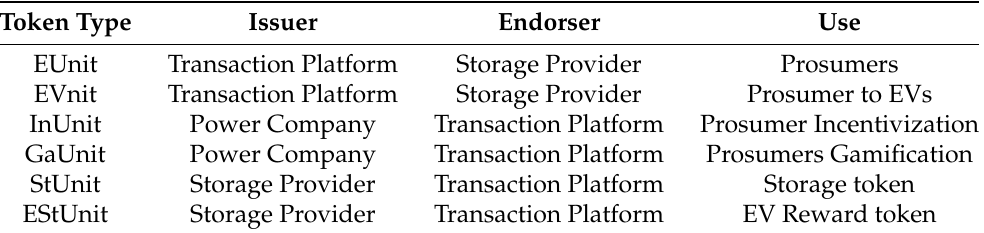
Table 1. Token issuers, endorsers and usage.